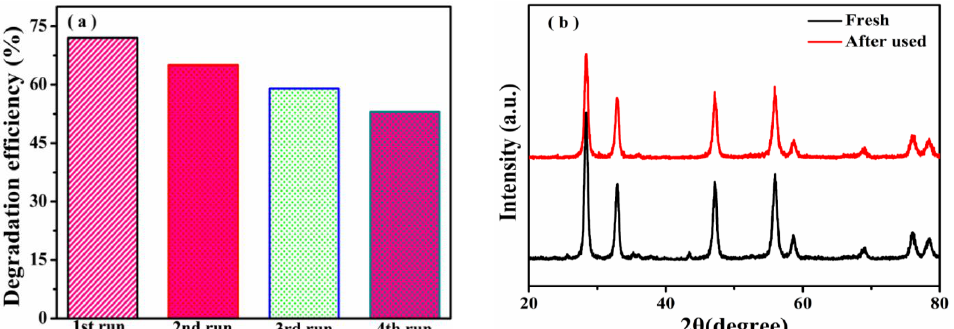
Figure 8. ( a ) Degradation efficiency of TC-HCl during different cycles, (Reaction conditions: initial pH value = 7, T = 25 °C, initial H 2 O 2 concentration = 100 μL, concentration of TC -HCl = 40 mg·L −1 , and catalyst dosage = 1 g·L −1 ); ( b ) XRD patterns of 0.1% CuS/Bi 2 WO 6 heterostructure before and after photo-Fenton reaction.